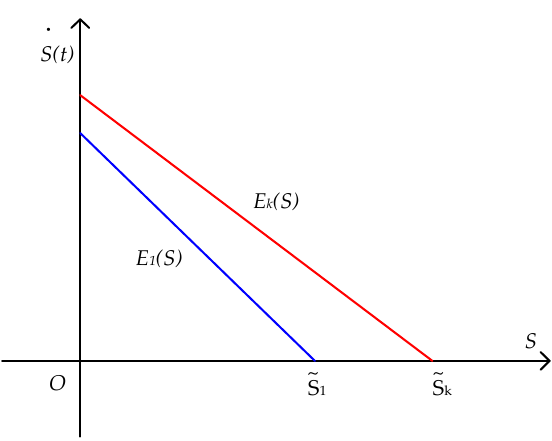
Figure 3. Comparison of the sewage stocks.